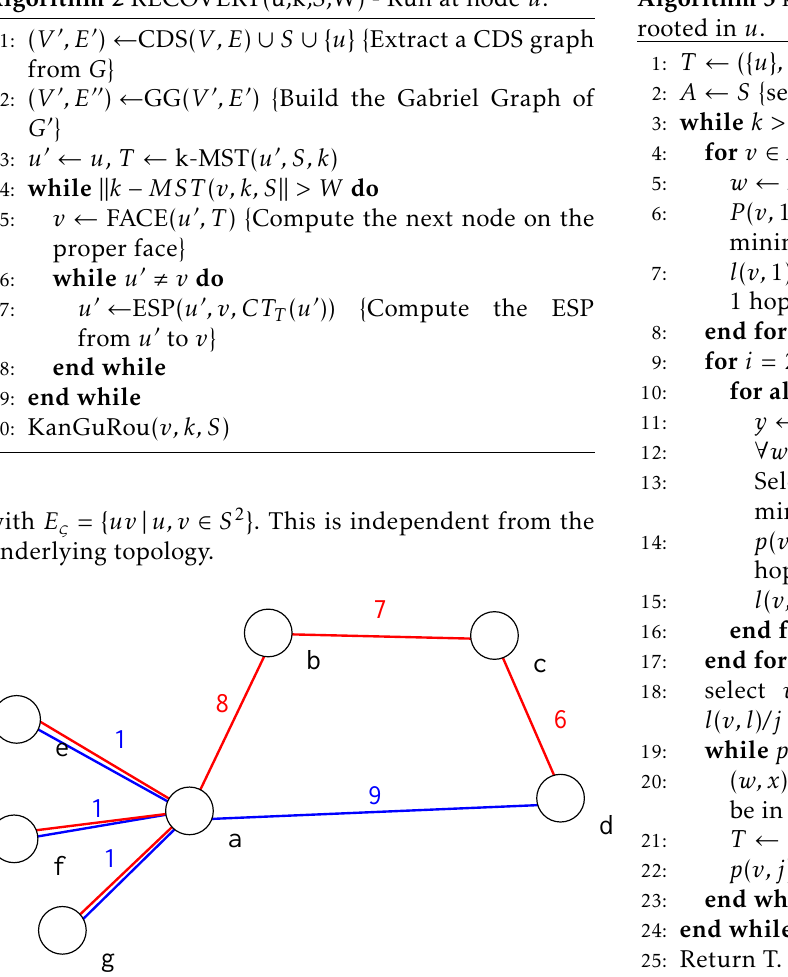
Figure 2. Illustration of MST and k -MST for k = 4 . If root is node d , the optimal 4 -MST (in blue) includes edges